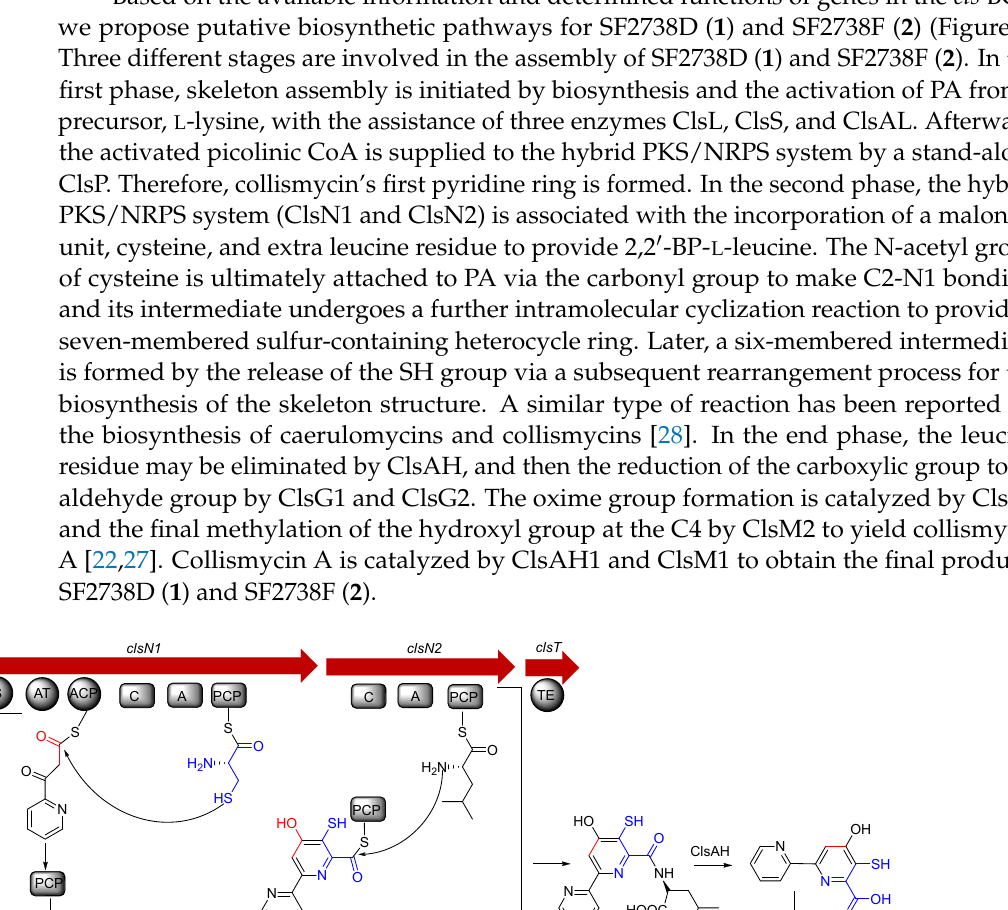
Figure 5. Genetic organization of actinomycin D biosynthesis gene clusters (BCGs) of S. griseus SCSIO PteL053 ( A ), Streptomyces costaricanus SCSIO ZS0073 ( B ), Streptomyces chrysomallus ATCC11523 ( C ), Streptomyces antibioticus IMRU 3720 ( D ), and Streptomyces parvulus ( E ).